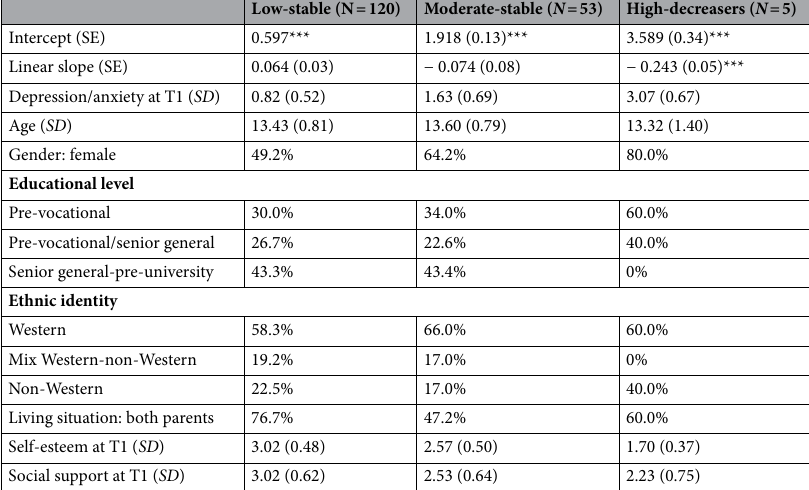
Table 6. Descriptives of the three latent classes of depression and anxiety. *** p < .001; ** p < .01; * p <